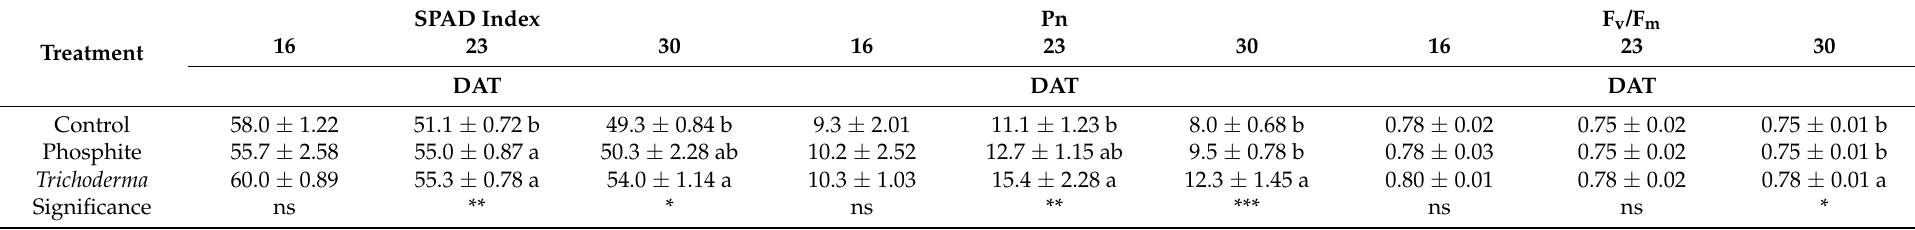
Table 3. Effects of phosphite and Trichoderma application on SPAD index, Carbon dioxide assimilation rate (Pn; µ mol CO 2 m − 2 s − 1 ), and Fv/Fm ratio of zucchini squash